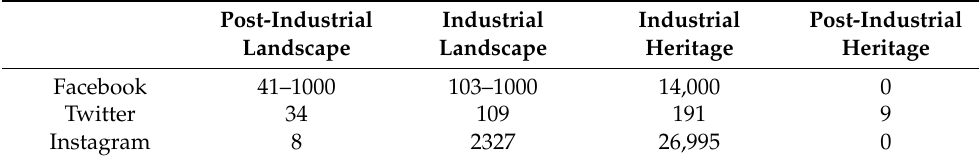
Table 3. Results of sampling #1 with data relating to tags on the three social media